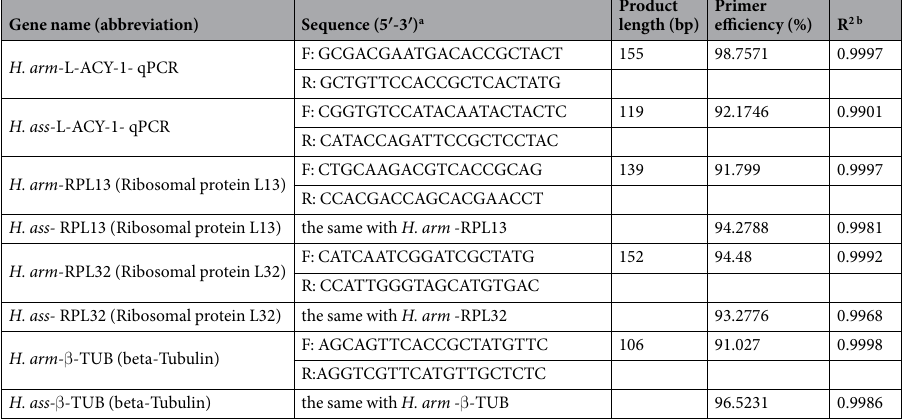
gene-specific primer H. ass -ACY-5 ′ (5 ′ RACE) or H. ass -ACY-3 ′ (3 ′ RACE) following the setup and touchdown cycling procedure described in the manufacturer manual. The final full-length PCR reaction (50 µ L) was composed of 3 µ L diluted H. assulta cDNA, 5 µ L 10 × LA Taq